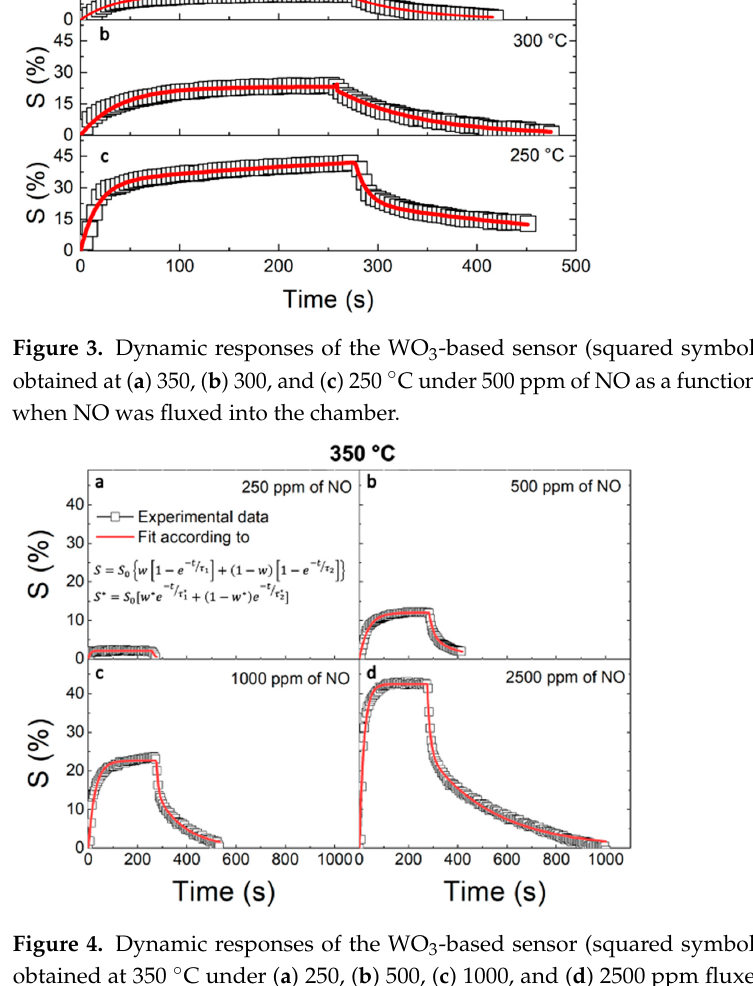
Figure 3. Dynamic responses of the WO 3 -based sensor (squared symbols) and the fit (red lines) ob- tained at ( a ) 350, ( b ) 300, and ( c ) 250 °C under 500 ppm of NO as a function of elapsed time, starting when NO was fluxed into the chamber. Figure 4. Dynamic responses of the WO 3 -based sensor (squared symbols) and the fit (red lines) ob- tained at 350 °C under ( a ) 250, ( b ) 500, ( c ) 1000, and ( d ) 2500 ppm fluxes of NO as a function of elapsed time.